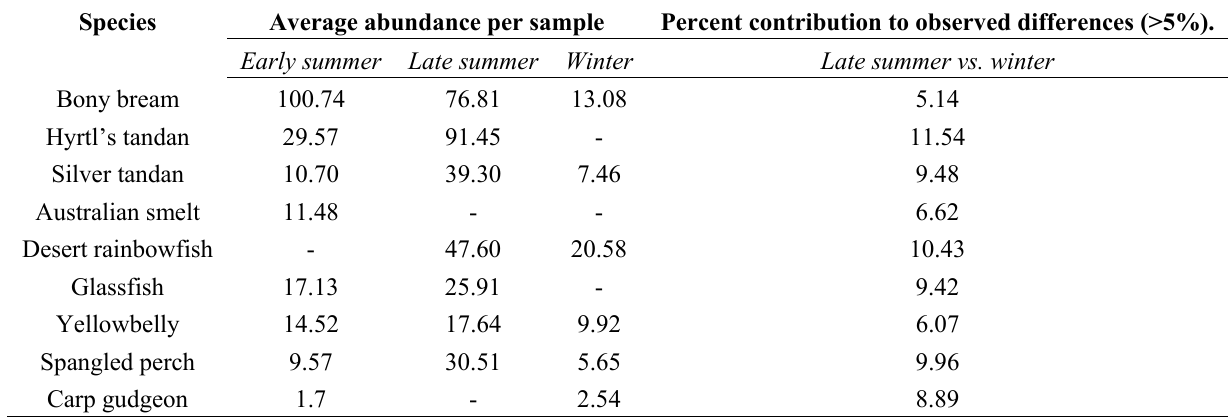
Table 3. SIMPER analysis comparing fish species presence/absence in relation to season (or sampling time) in the Queensland Lake Eyre Basin from April 2007–March/April 2008. (Early summer = September–December, late summer = January–April, winter = May–August.) Species Average abundance per sample Percent contribution to observed differences (>5%). Early summer Late summer Winter Late summer vs. winter